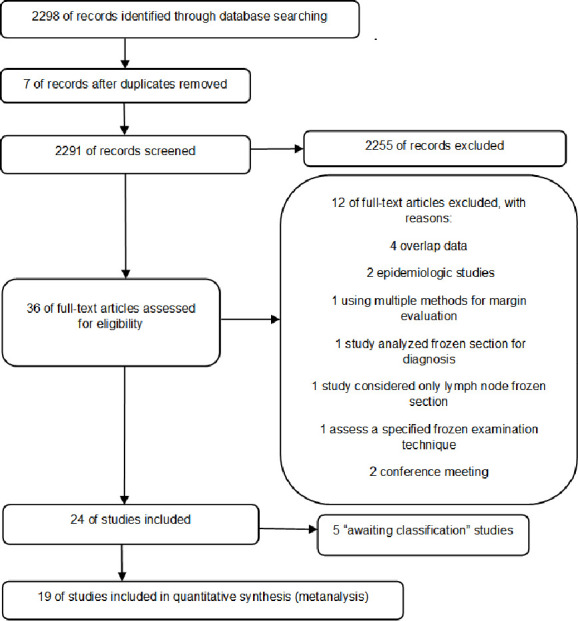
PRISMA flowchart.